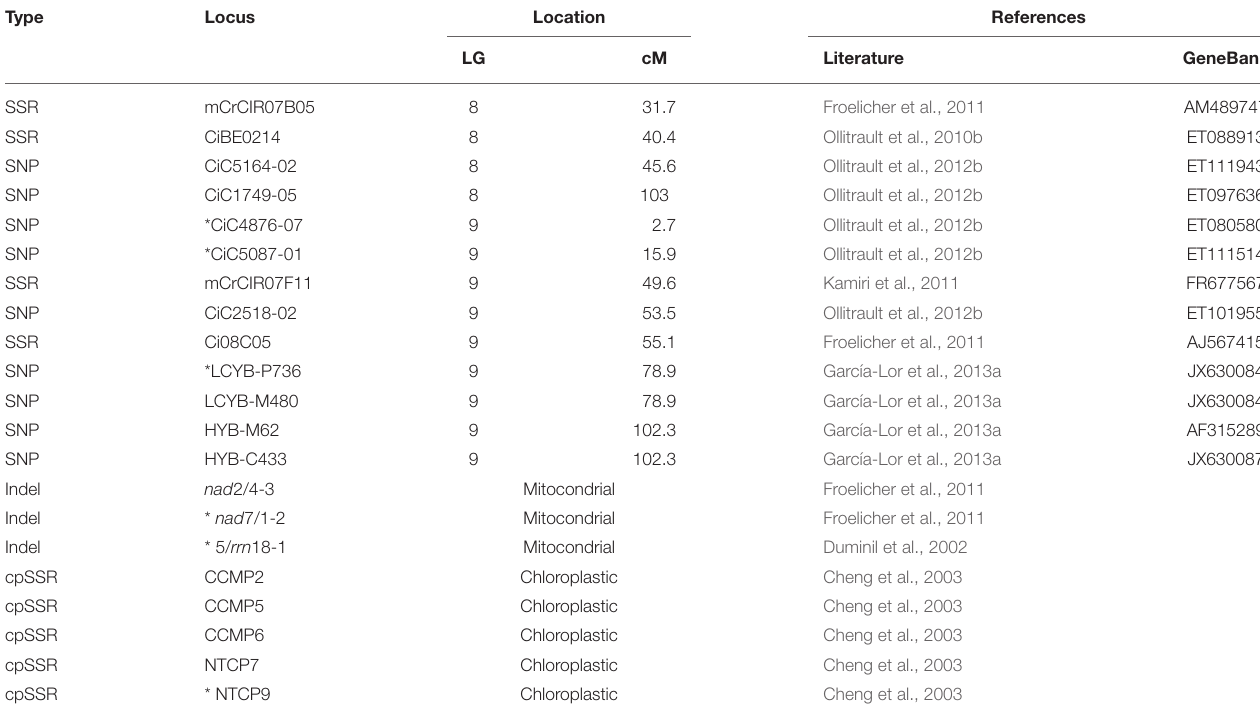
TABLE 4 | Molecular markers analyzed indicating the type of marker, locus name, linkage groups (LGs) 8 and 9 and location within LG in centimorgans (cM), bibliographic reference in the literature, and GeneBank